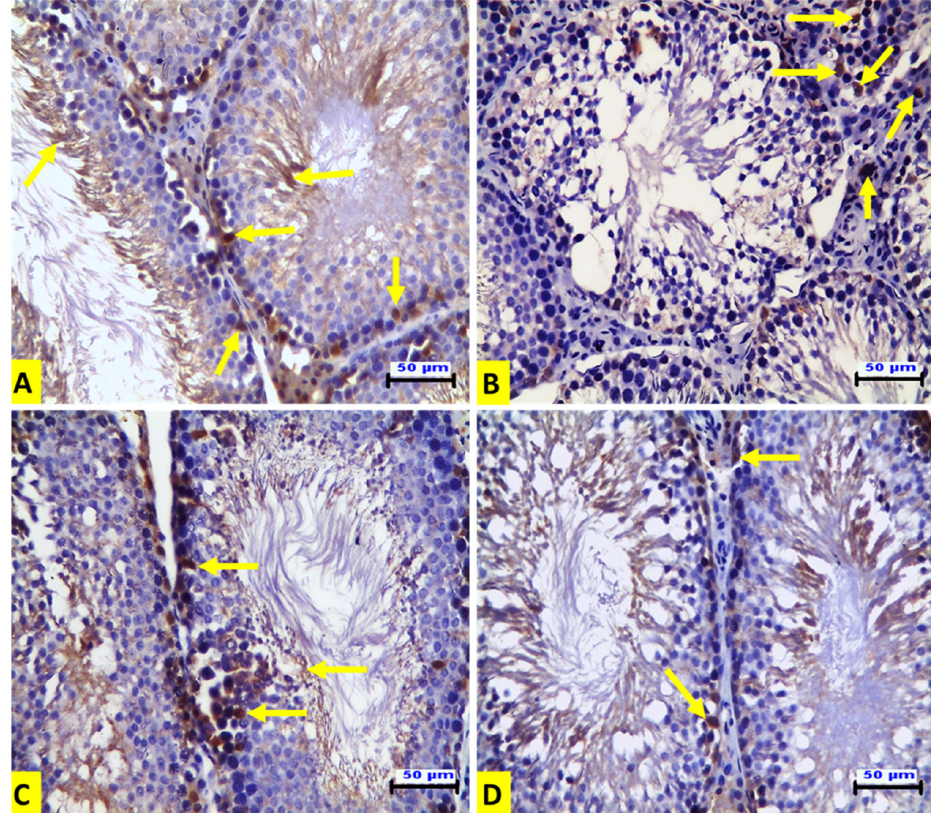
Figure 3. Representative histopathological photomicrographs of transverse sections from rat testes (IHC for Ki-67 X 20 , scale bar 50 μ m). ( A ) The control group exhibits Ki-67 immunostaining in the spermatogenic cells of the seminiferous tubules with strong positive Ki-67 immunostaining in the spermatogonia and spermatocytes (arrows). ( B ) The ACR-treated group shows negative Ki-67 immunostaining in the seminiferous tubules and strong Ki-67-positive immunostaining in the hyperplastic Leydig cells. ( C ) The EE-treated rats show strong Ki-67-positive immunostaining in the spermatogenic cells of the seminiferous tubules. ( D ) The EE + ACR group shows weak immunostaining for Ki-67 in the spermatogenic cells of the seminiferous tubules.